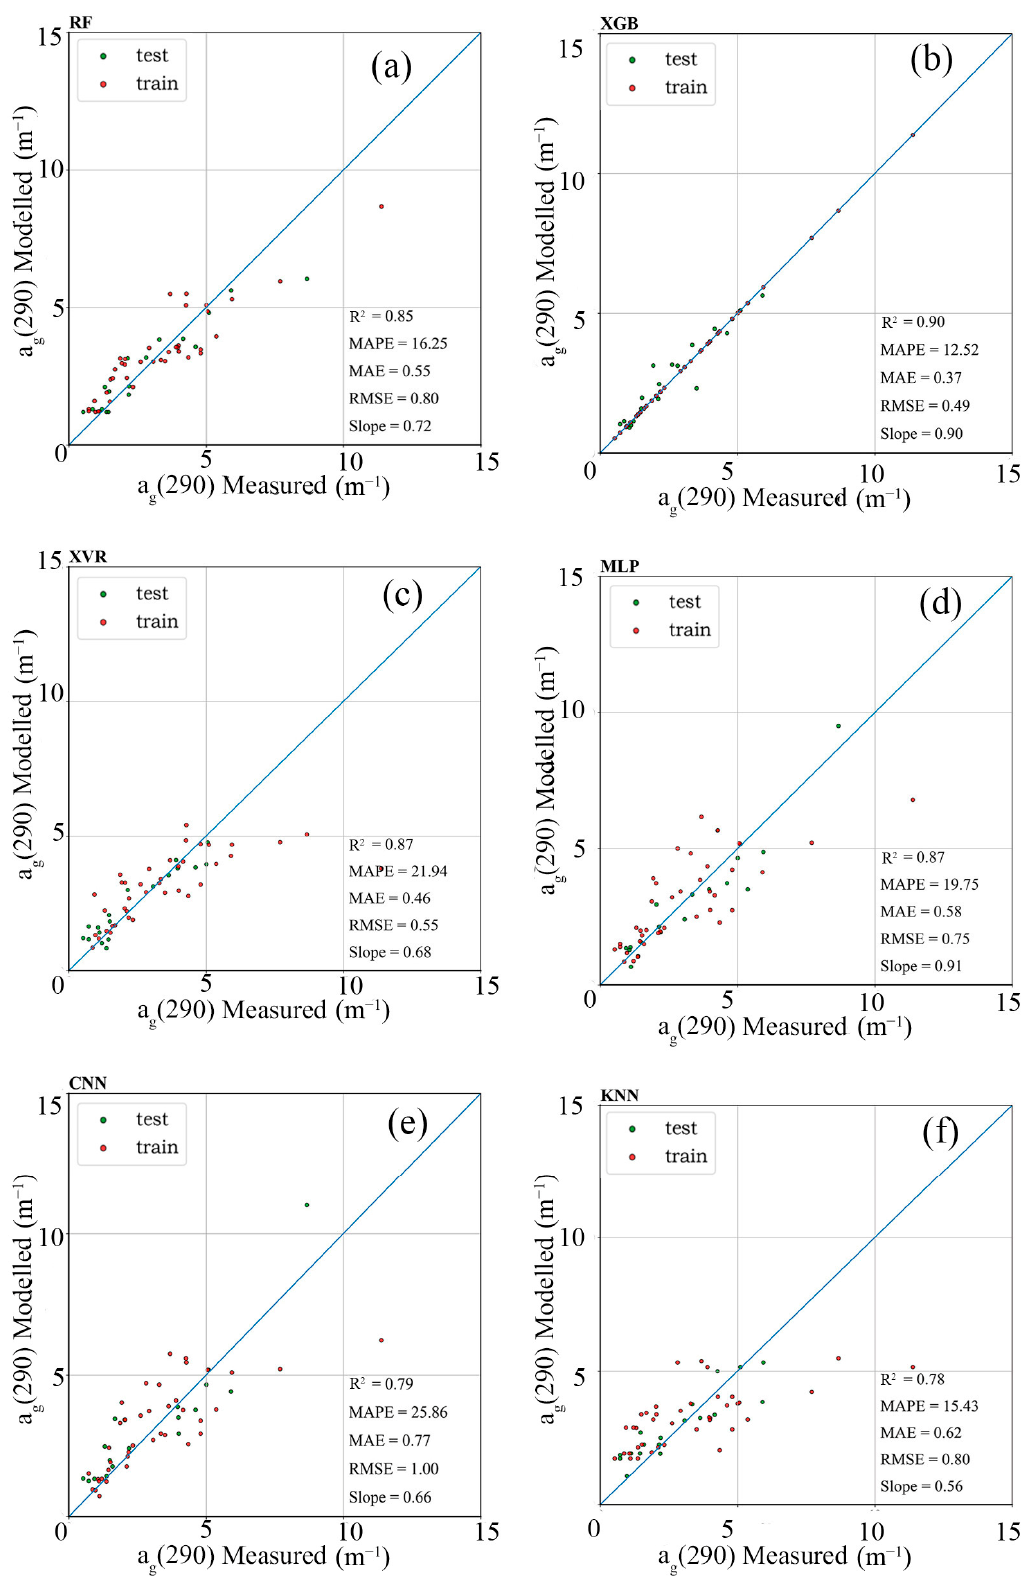
Figure 2. Scatter plots of in-situ a g (290) versus estimated values from the machine learning algorithms of the RF ( a ), XGB ( b ), XVR ( c ), MLP ( d ), CNN ( e ), and KNN ( f ); the red dots are the training data set and the green dots are the test data set.